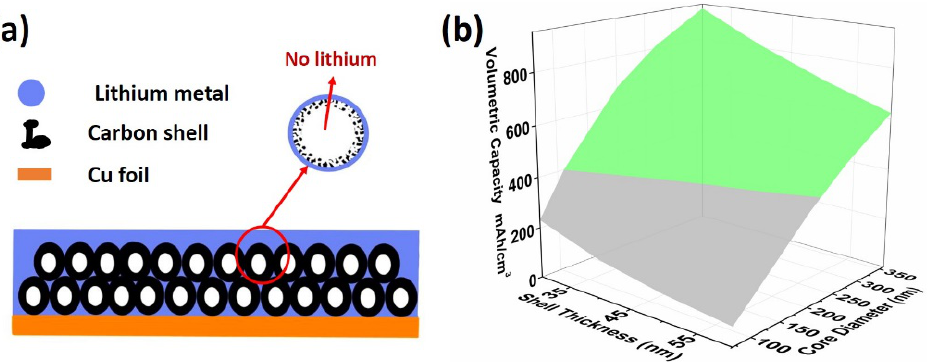
Figure 5. ( a ) Schematic of the mechanism of lithium deposition inside PHCCSs, and ( b ) theoretical volumetric capacity of PHCCS coatings of different core sizes and shell thicknesses.